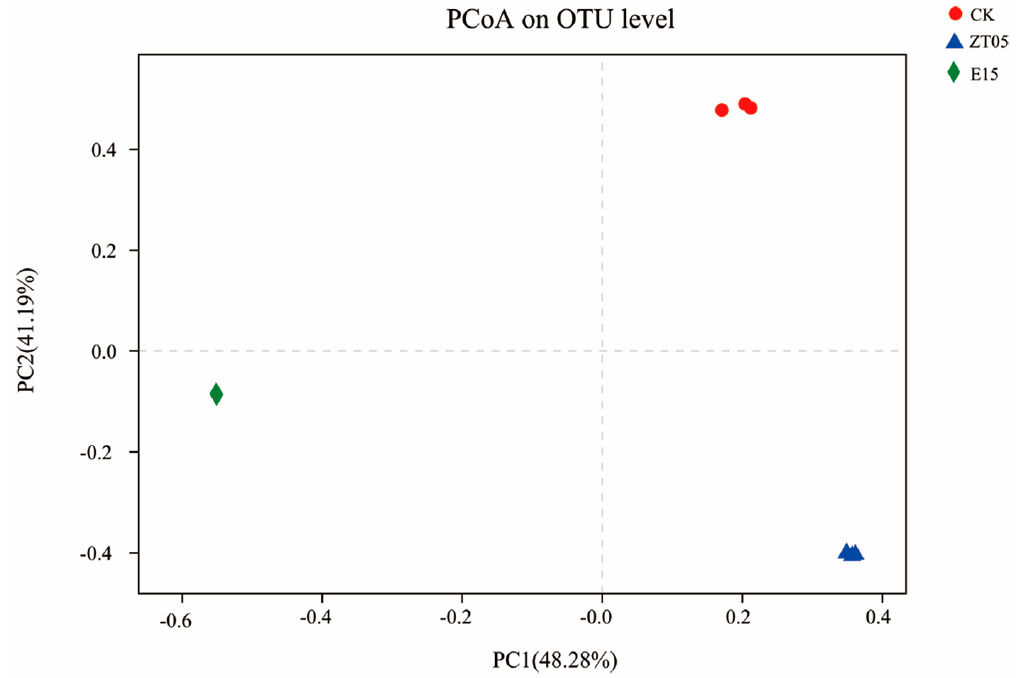
Figure 6. PCoA(Principal co-ordinates analysis) ordination based on Bray–Curtis similarities of fungal communities at CK, ZT05, E15 treatments. CK: inoculation with PD blank culture medium. ZT05: single inoculation with T. virens ZT05. E15: single inoculation with T. harzianum E15.